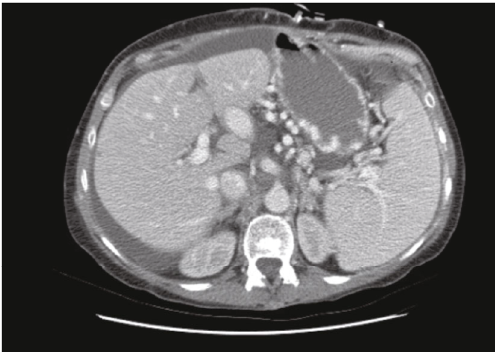
Figure 2: Posttransplant CT scan demonstrating large varices, splenomegaly, and ascites.